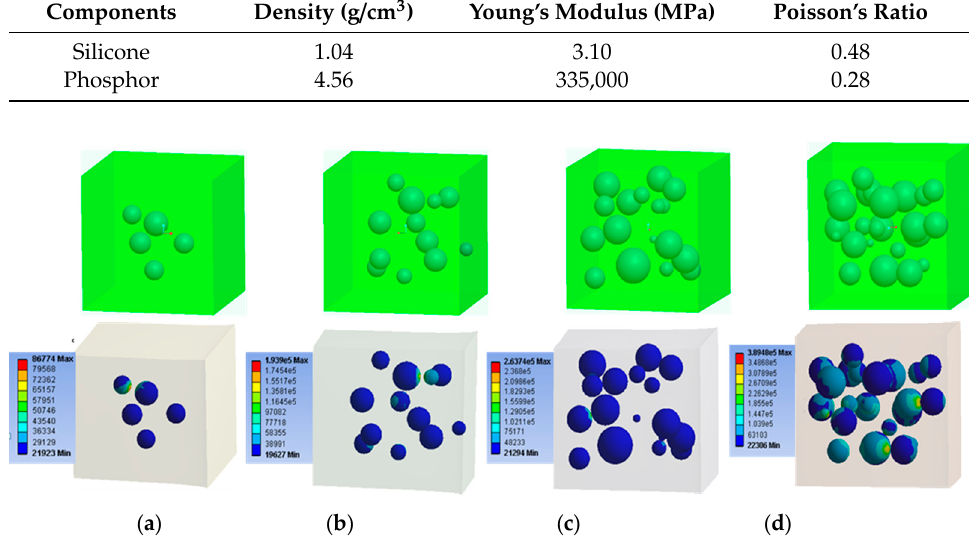
Figure 11. Volume element models and transient mechanical simulation results of phosphor/silicone composites ( a ) 5%; ( b ) 10%; ( c ) 15%; ( d ) 20%.